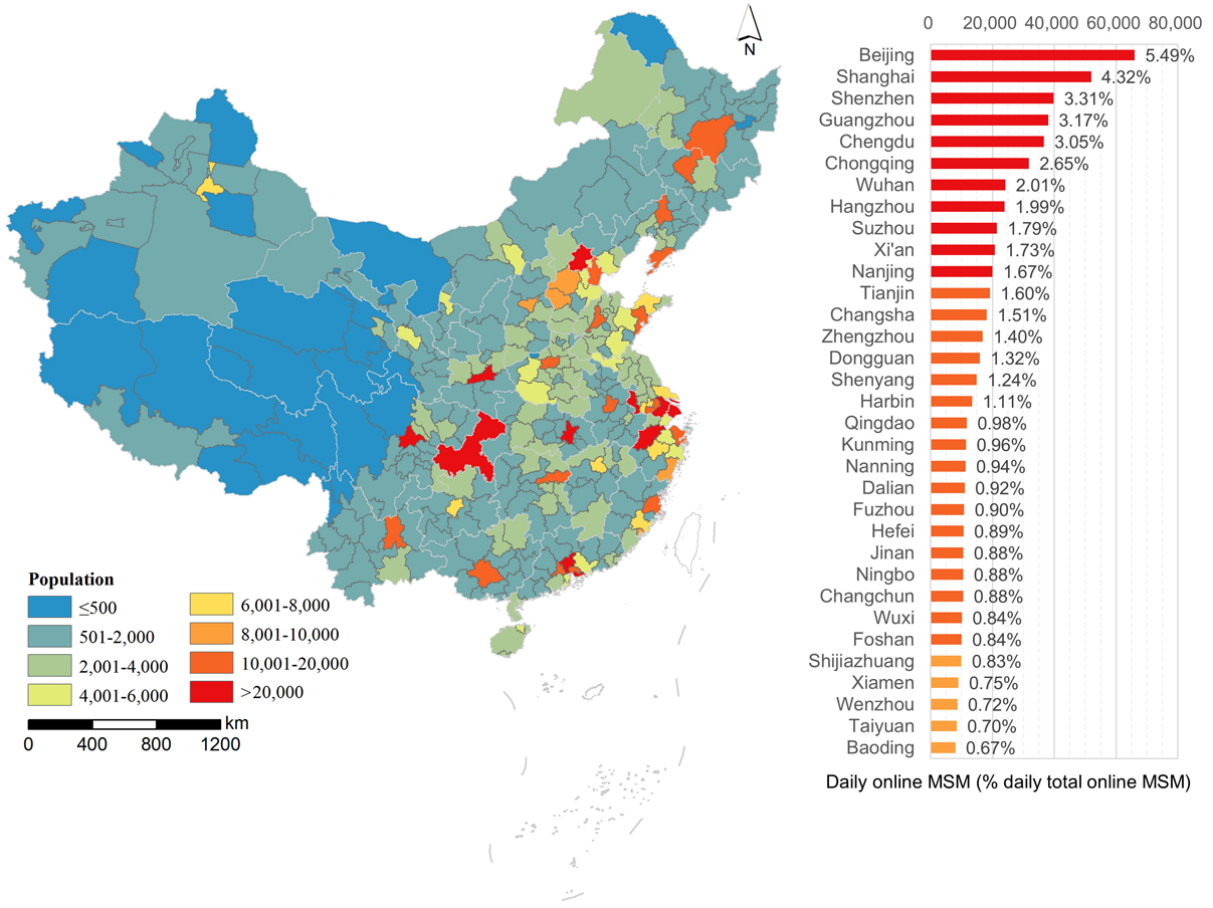
Figure 3. City-level distribution of daily online MSM from nonholiday social